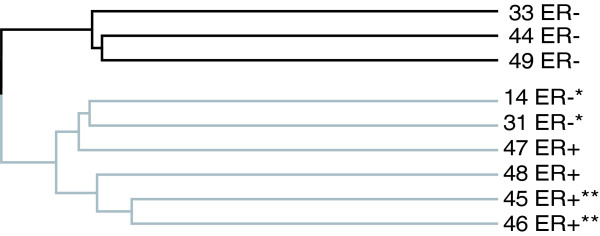
Separation of ER- and ER+ breast cancer samples. According to the immunoblotting classification, our method has two misclassified samples, namely 14 and 31. However, both samples are placed at the furthest end of the ER+ cluster and are joined in a single branch, possibly indicating an intermediate disease stage.